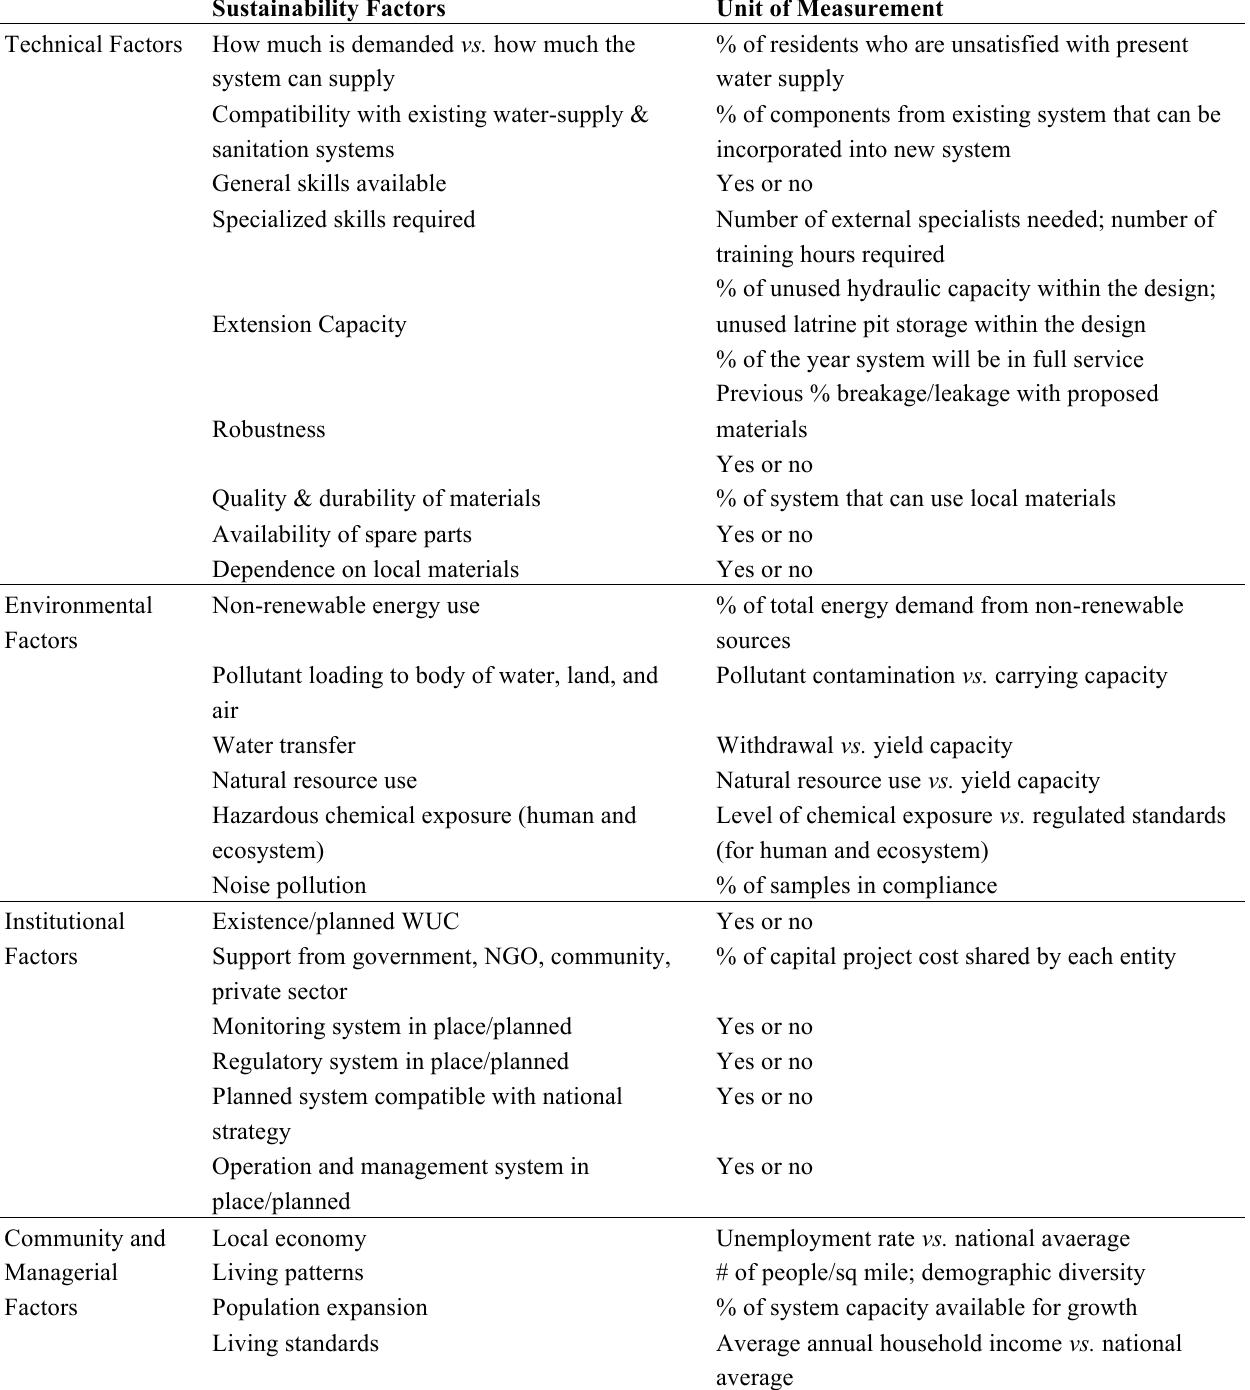
Table 1. Sustainability factors for water system design